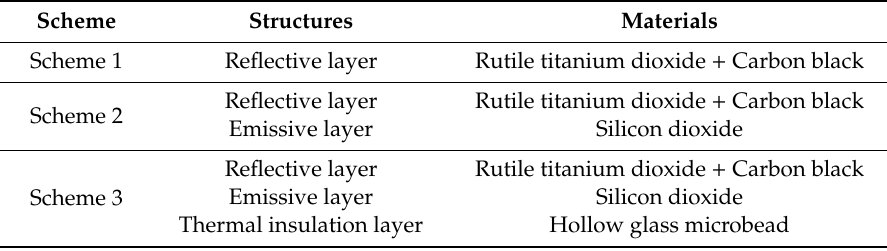
Table 4. Coating scheme on test samples.